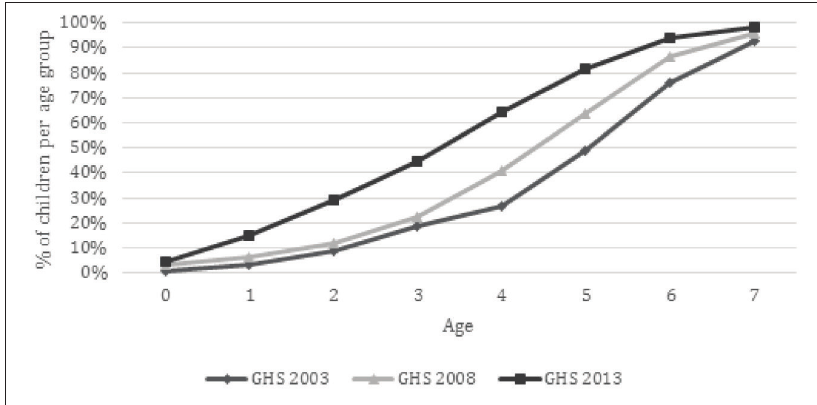
Figure 1: Overall enrolment rates of children in any educational institution (Source: SSA 2014). Notes: The categories considered in the calculations are primary schools, Grade R, preschools, crèches and ECD centres.